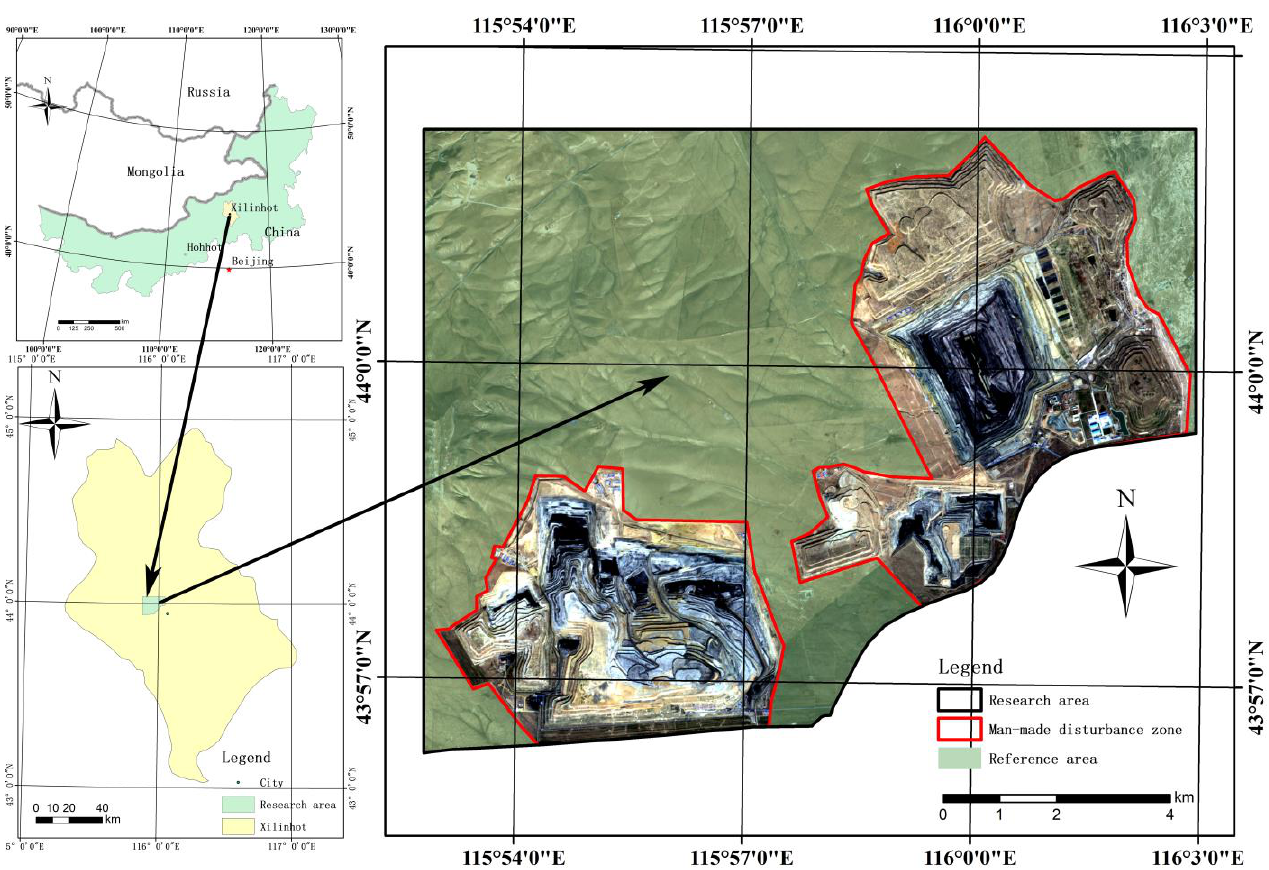
Figure 1. Location of the study area: Xilinhot City, Inner Mongolia Autonomous Region, China (Sentinel-2A remote sensing image, true color).